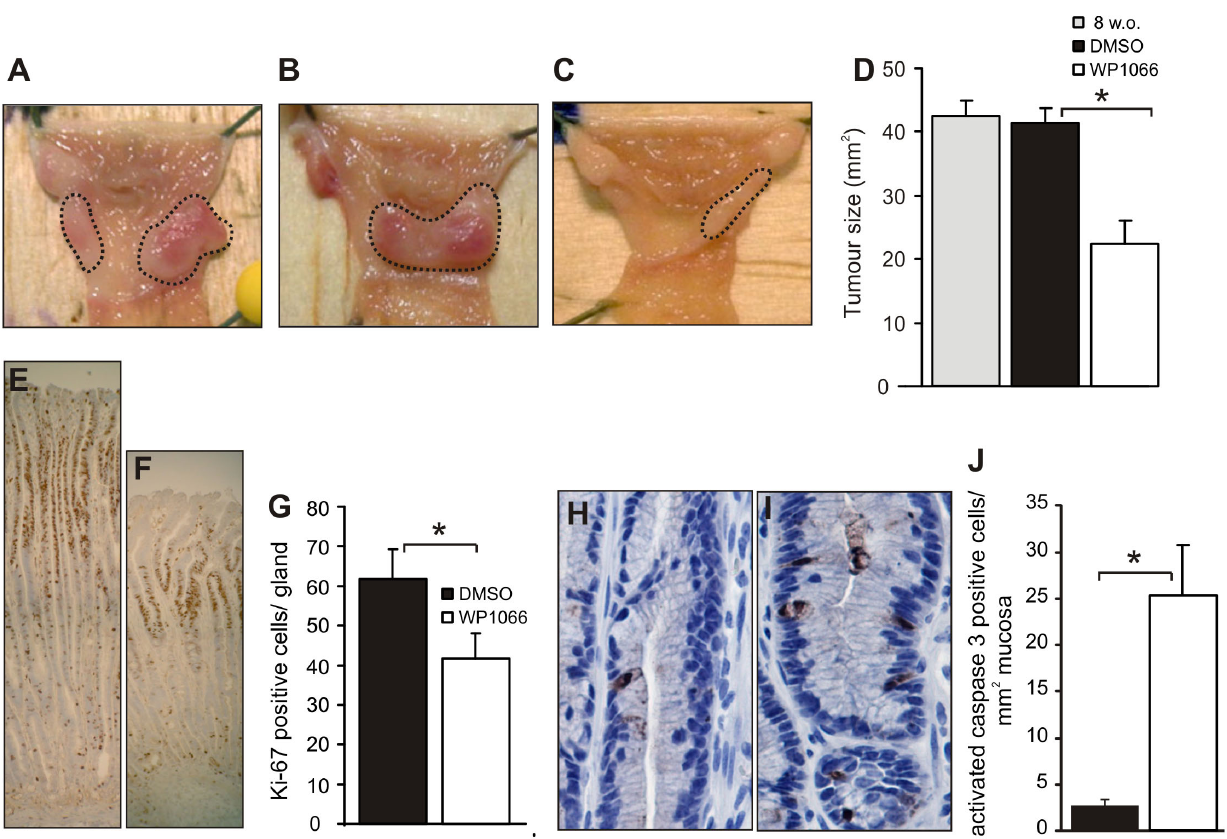
Figure 3. Treatment of gp130 757FF mice with WP1066 reduces tumour size. gp130 757FF mice (8 weeks old) were treated i.p with 10 mg/kg of WP1066 or DMSO twice with a gap of one day between doses, followed by doses of 20 mg/kg every 2 days for 2 weeks. Antral tumours in 8 week untreated mice (A) and 10 week DMSO-treated vehicle controls (B) were no different in mean area, however WP1066 treatment resulted in , 50% smaller tumours (C). This was confirmed by quantitative morphometry (D) where antral tumours were significantly smaller in WP1066 mice compared to 10 w.o. DMSO controls and 8 w.o. untreated mice (n=7–10; p , 0.05). The effect of WP1066 on cell proliferation was assessed by staining sections with an antibody for Ki-67. There was a significant decrease in the number of Ki-67 positive cells per gland in the WP1066 treated mice (F) compared to controls (E) and quantified graphically (G). The number of apoptotic cells quantified after caspase 3 staining of antral sections of a DMSO control (H) and WP1066 (I) mouse, and was quantified by counting stained cells/mm 2 of gastric mucosa